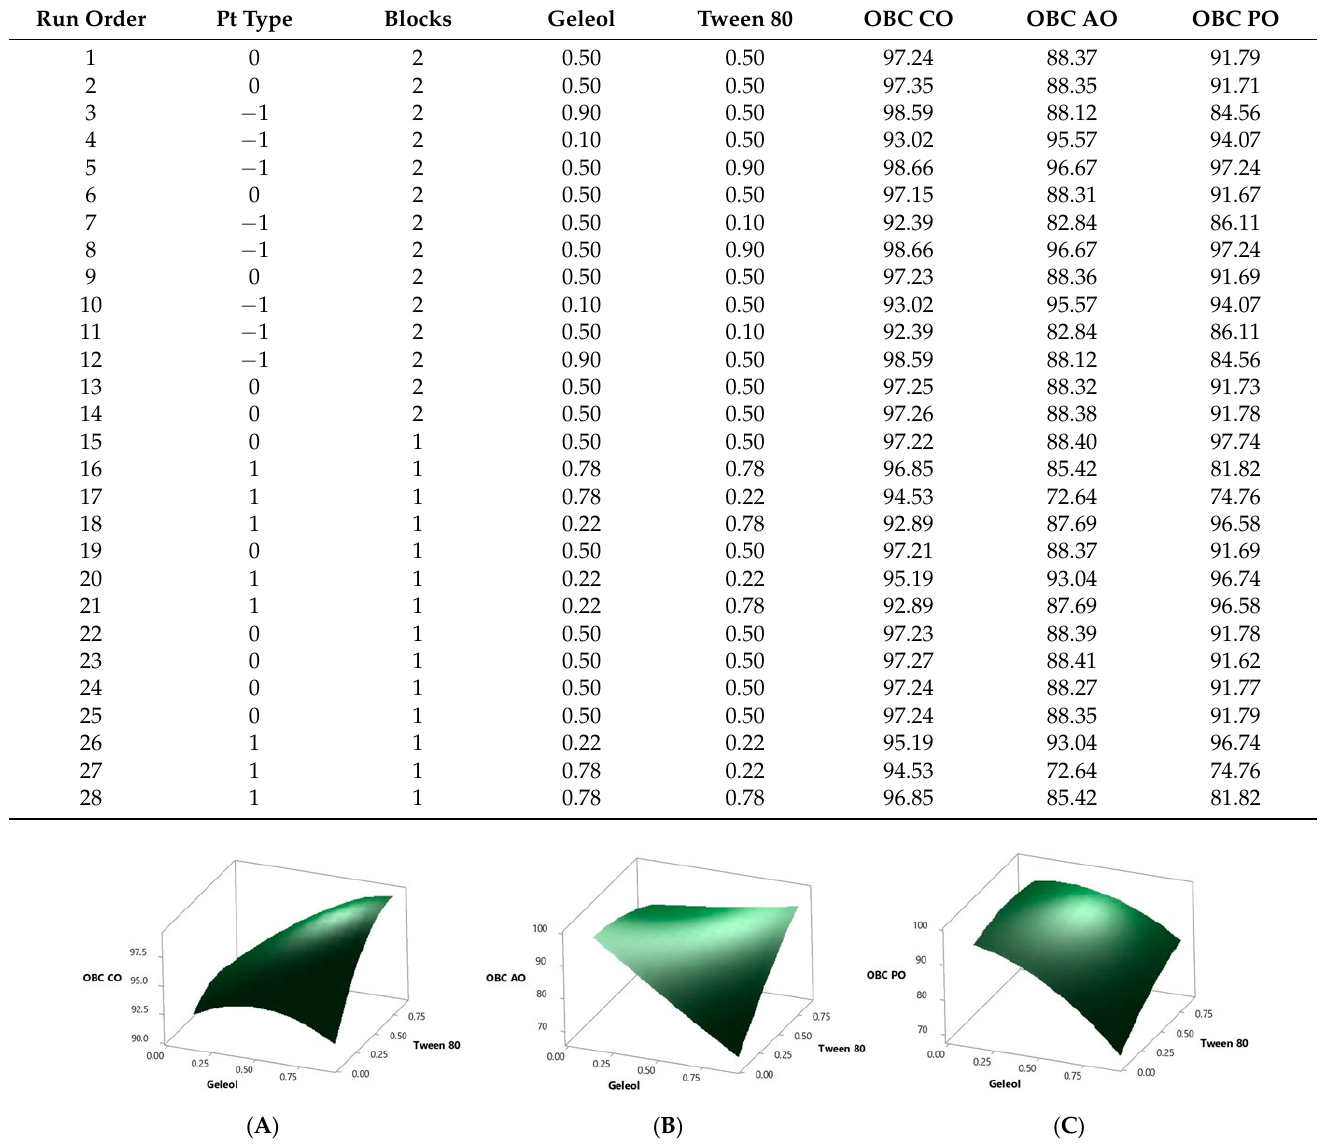
Figure 1. Response surfaces for oil-binding capacity (OBC) optimization (( A )-coconut oil, ( B )-avocado oil, and ( C )-pomegranate oil).